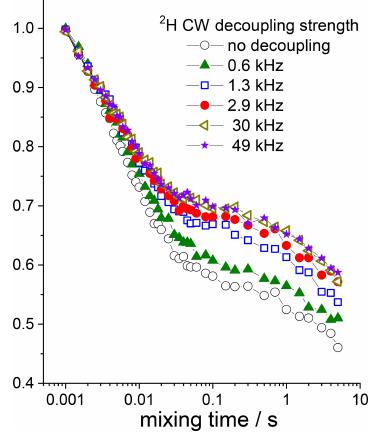
Figure 15. 15 N dipolar CODEX mixing time dependences (COS component) measured in GB1 protein sample at various 2 H CW decoupling strengths during the de(re)phasing periods. Z filter 0.1s between the CP section and the dephasing period was applied, MAS 20kHz, t 13 ◦ C, NT R 2ms.